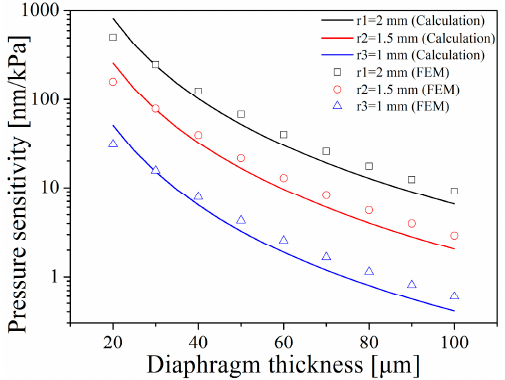
Figure 3. The pressure sensitivity varies with the dimensions of the sensor diaphragm. The dependency is evaluated here by theoretically calculation and by FEM, respectively.